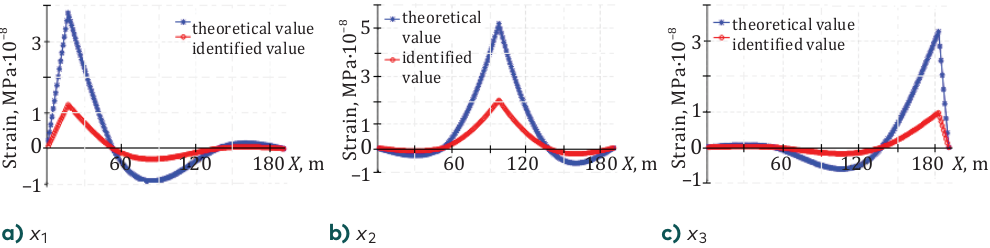
Figure 21. Identified strain influence lines using the measured